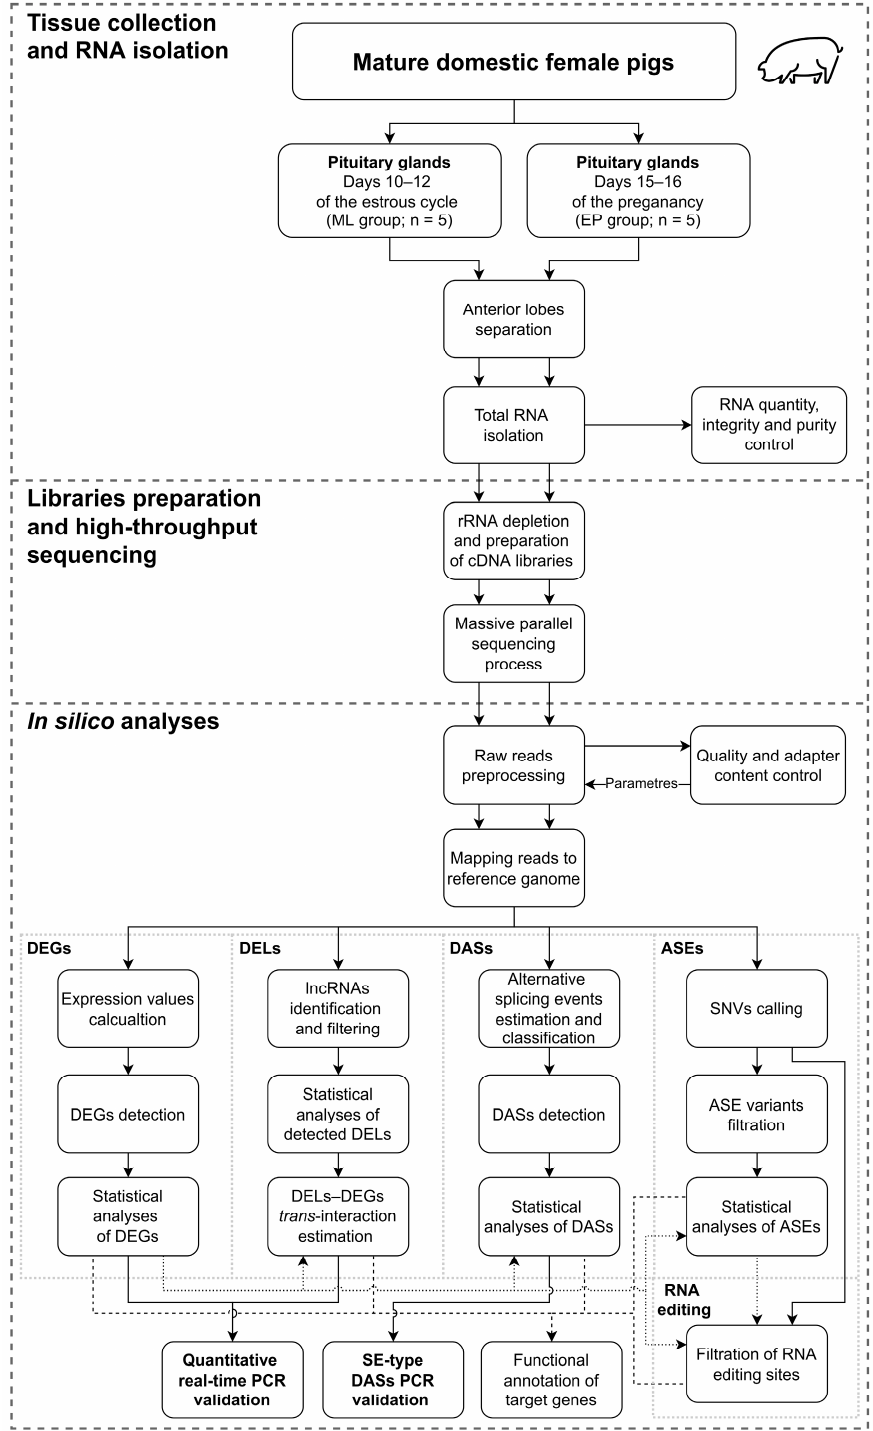
Figure 8. A stage-by-stage fl owchart of the experiment performed in the scope of this article.